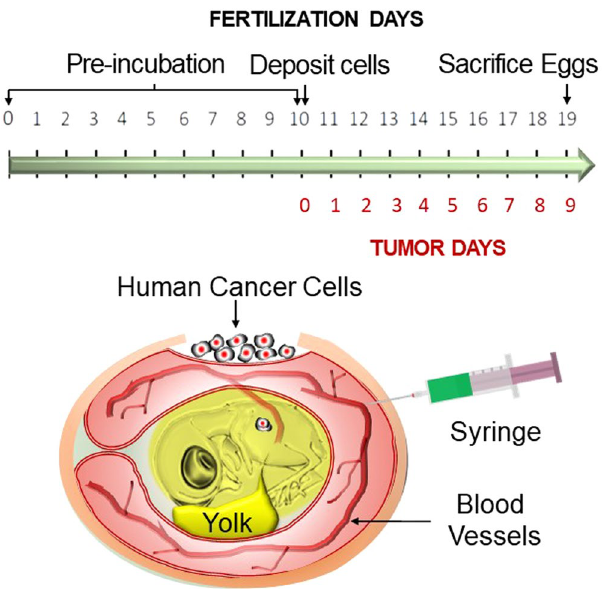
Figure 1. A timeline of the experiment. Fertilized eggs are incubated for ten days at which time human cancer cells are transplanted onto the CAM membrane. Tumor is formed three days later. Nanoparticles loaded with anticancer drug are injected into the vein and effect on tumor growth is